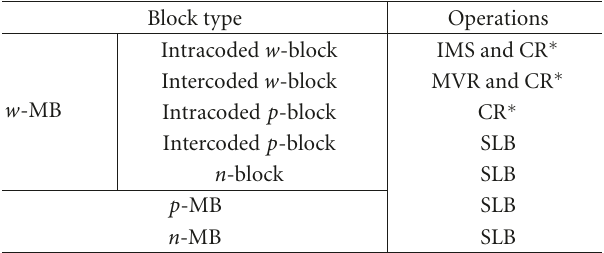
Table 4: Corresponding operations of each block type during the VET transcoding.